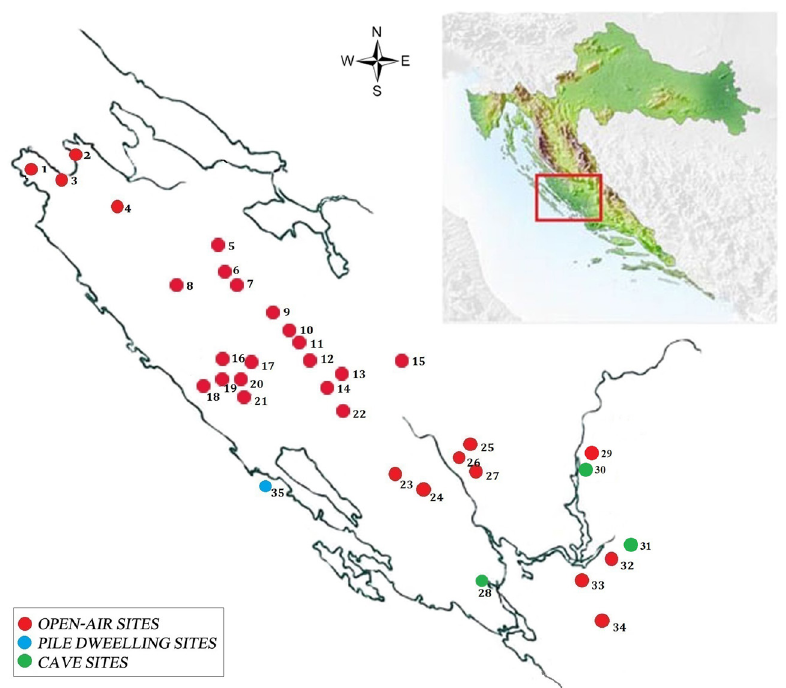
Figure 2: All currently known neolithic sites in Northern Dalmatia: ( 1 ) Privlaka, ( 2 ) Vrsi, ( 3 ) Nin, ( 4 ) Crno vrilo, ( 5 ) Islam Gr č ki, ( 6 ) Smil č i ć , ( 7 ) Biljane Donje, ( 8 ) Zemunik Donji, ( 9 ) Kula Atlagi ć , ( 10 ) Kula Atlagi ć , ( 11 ) Benkovac ( Brdine ) , ( 12 ) Benkovac ( Barice ) , ( 13 ) Bukovi ć ( Vrcelji ) , ( 14 ) Lisi č i ć , ( 15 ) Brgud, ( 16 ) Li š ane Tinjske, ( 17 ) Ra š tevi ć , ( 18 ) Sikovo, ( 19 ) Tinj, ( 20 ) Pola č a, ( 21 ) Gornja Jagodnja, ( 22 ) Lepuri, ( 23 ) Stankovci – Š iritovac, ( 24 ) Velim – Veli š tak, ( 25 ) Kriva č e, ( 26 ) Vrbica, ( 27 ) Ra š inovac, ( 28 ) Tradanj,